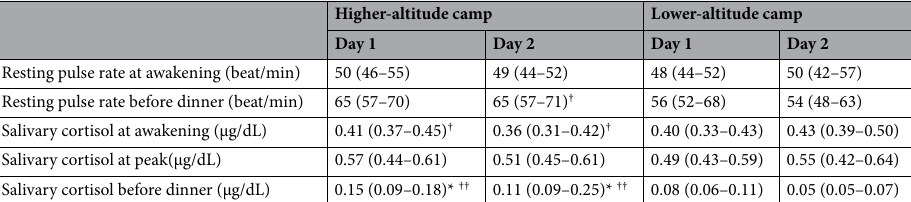
Table 3. Comparison of the variables between the higher- and lower-altitude camps in runners. Data are expressed as median (25th–75th percentile). * p < 0.05 and ** p < 0.01 comparing variables with day 1 at the lower-altitude camp using the Wilcoxon signed-rank test. † p < 0.05 and †† p < 0.01 comparing variables with day 2 at the lower-altitude camp using the Wilcoxon signed-rank